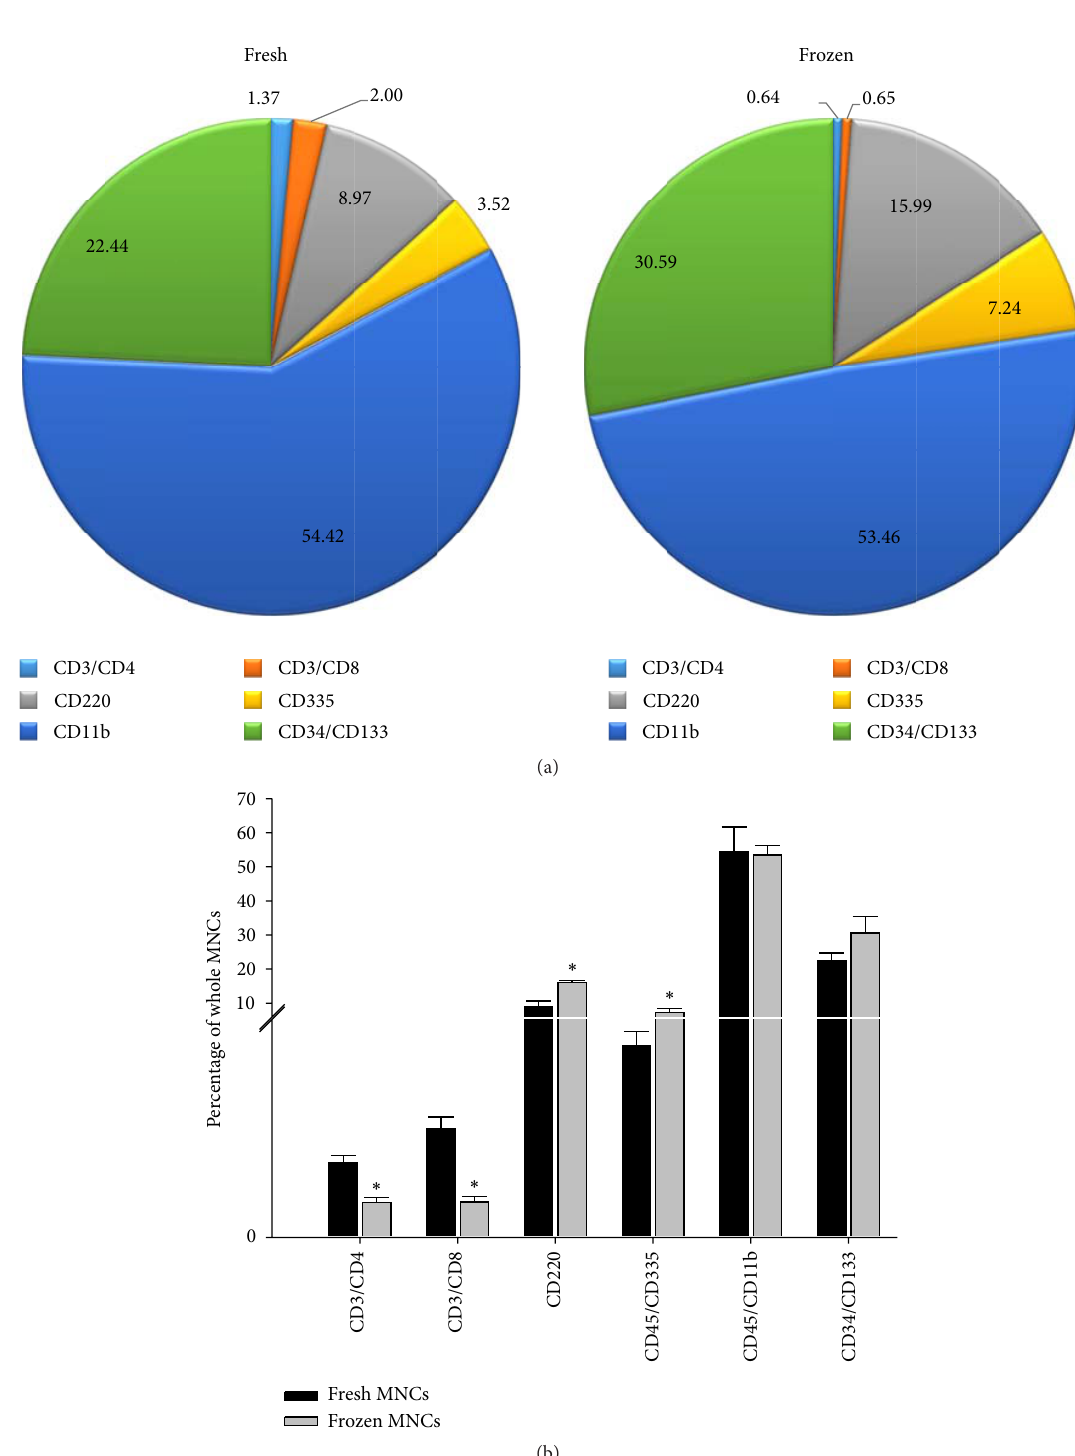
Figure 1: (a) Pie charts illustrating the mean percentage of certain cellular subpopulations within the whole MNCs. (b) Bar graphs exhibiting the significant changes in cellular subpopulation between fresh and cryopreserved MNCs group. Data are mean ± SD. ∗ : 𝑝 < 0.05 , fresh MNCs versus frozen MNCs. 𝑛 = 4